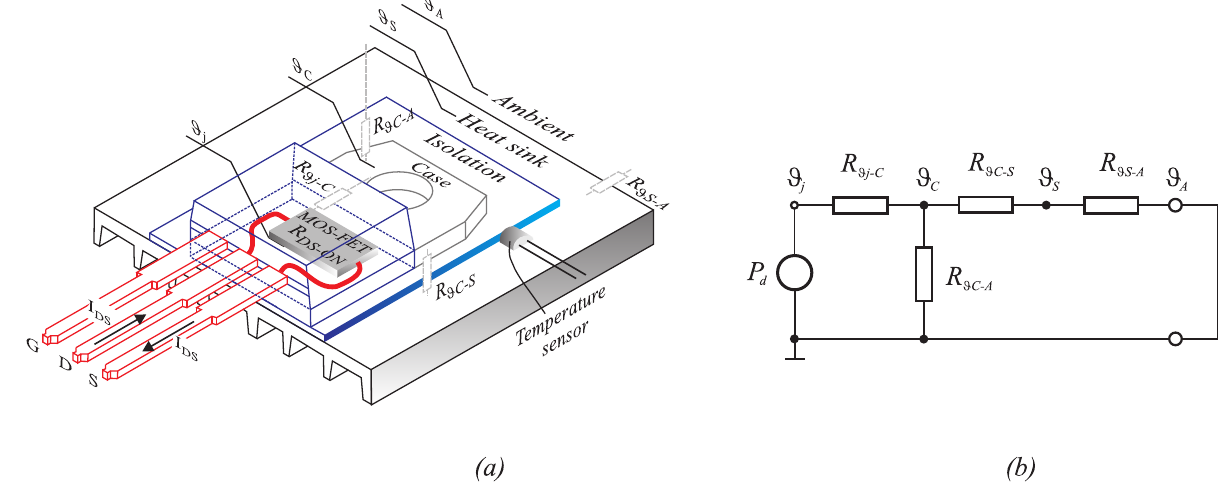
Figure 4. The MOS-FET TO-220 package; ( a ) thermal components inside the TO-220 package; ( b ) equivalent thermal circuit.